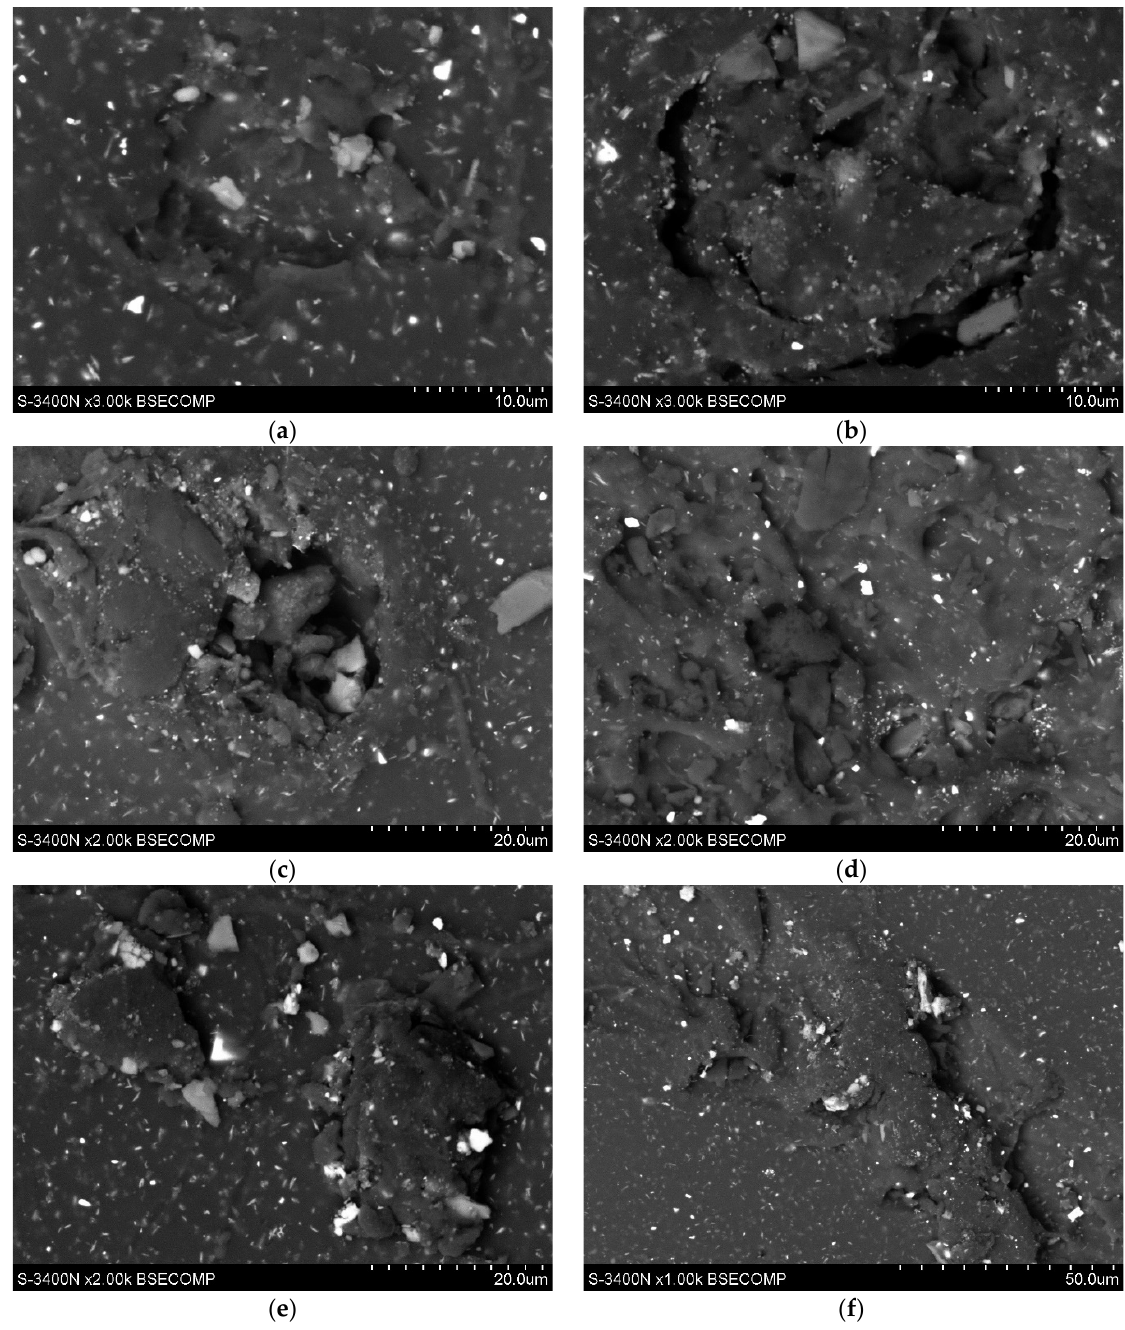
Figure 8. Selected forms of paint coating degradation in areas of bacterial colony development after 8 weeks of exposition. SEM, clusters of microfractures ( a , b ); cavities ( c – e ) and clusters of elongated shapes ( f